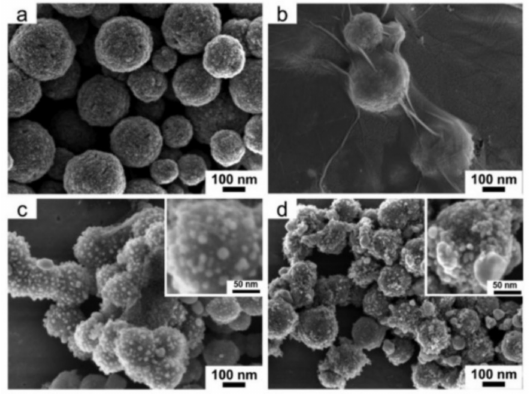
Figure 9. Typical FESEM images of ( a ) Fe 3 O 4 , ( b ) Fe 3 O 4 /GO, ( c ) Fe 3 O 4 /GO/Ag, and ( d ) Fe 3 O 4 /Ag microspheres. Inserts are magnified FESEM images of Fe 3 O 4 /GO/Ag and Fe 3 O 4 /Ag micro- spheres [94].